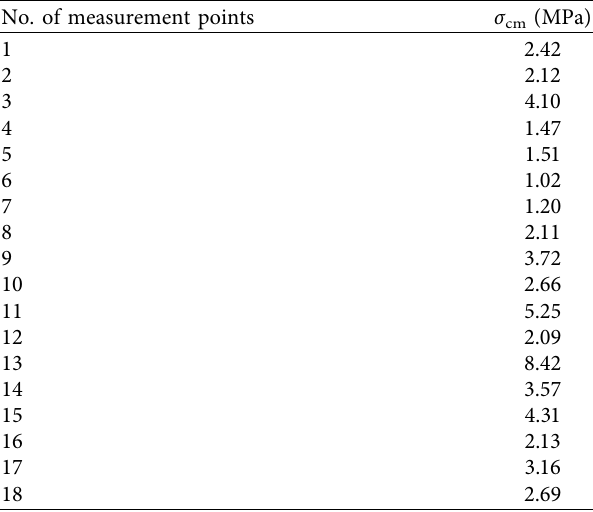
Table 6: σ cm at different measurement